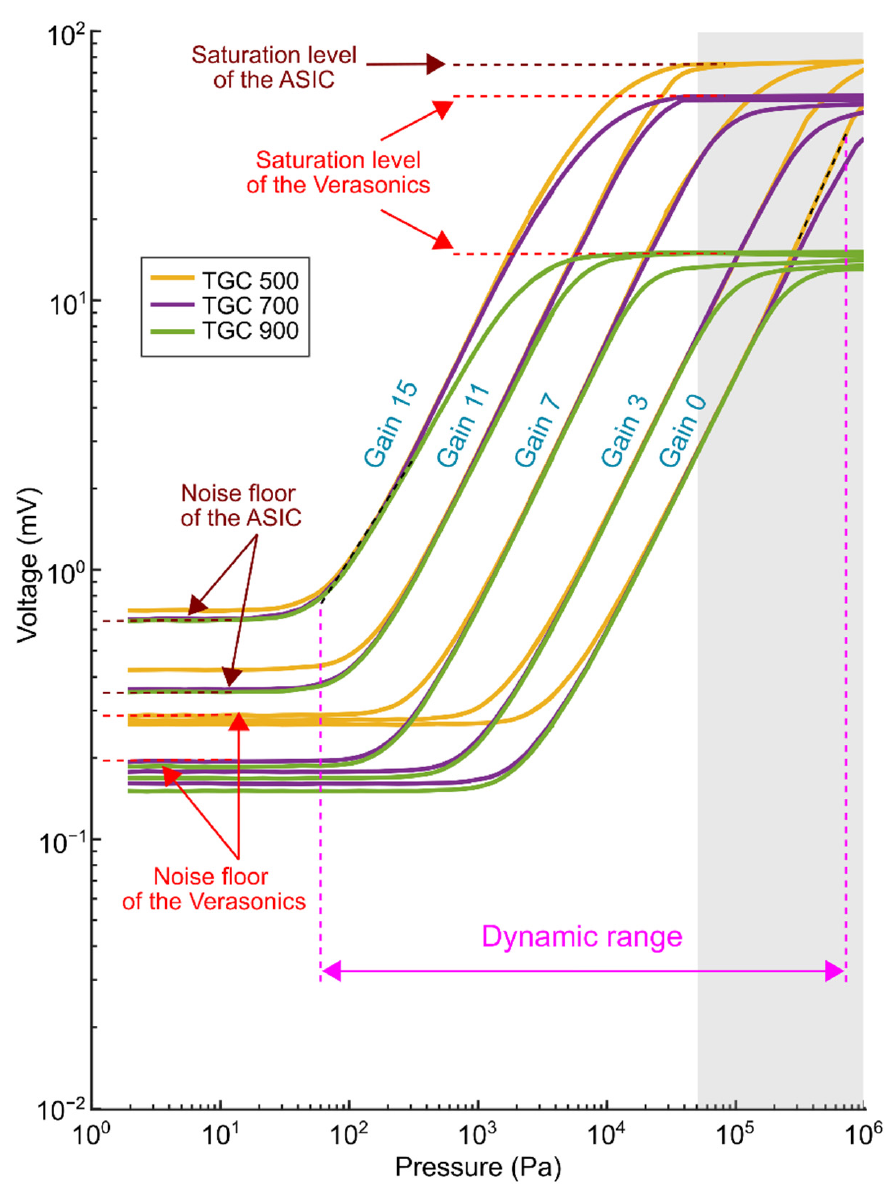
Figure 11. The relation between the received pressure and ASIC output voltage for different gain settings.